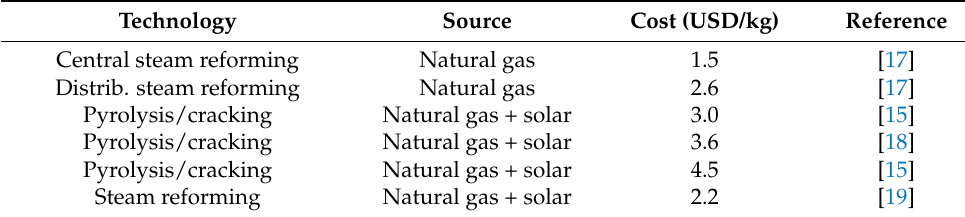
Table 1. Cost of hydrogen production technologies using natural gas.